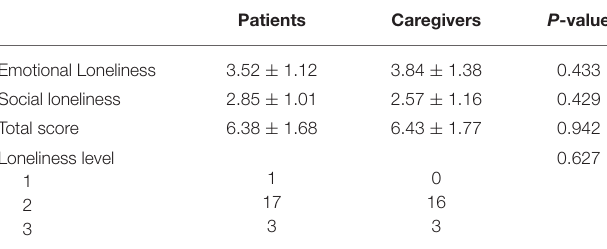
TABLE 4 | Loneliness scores in patients and